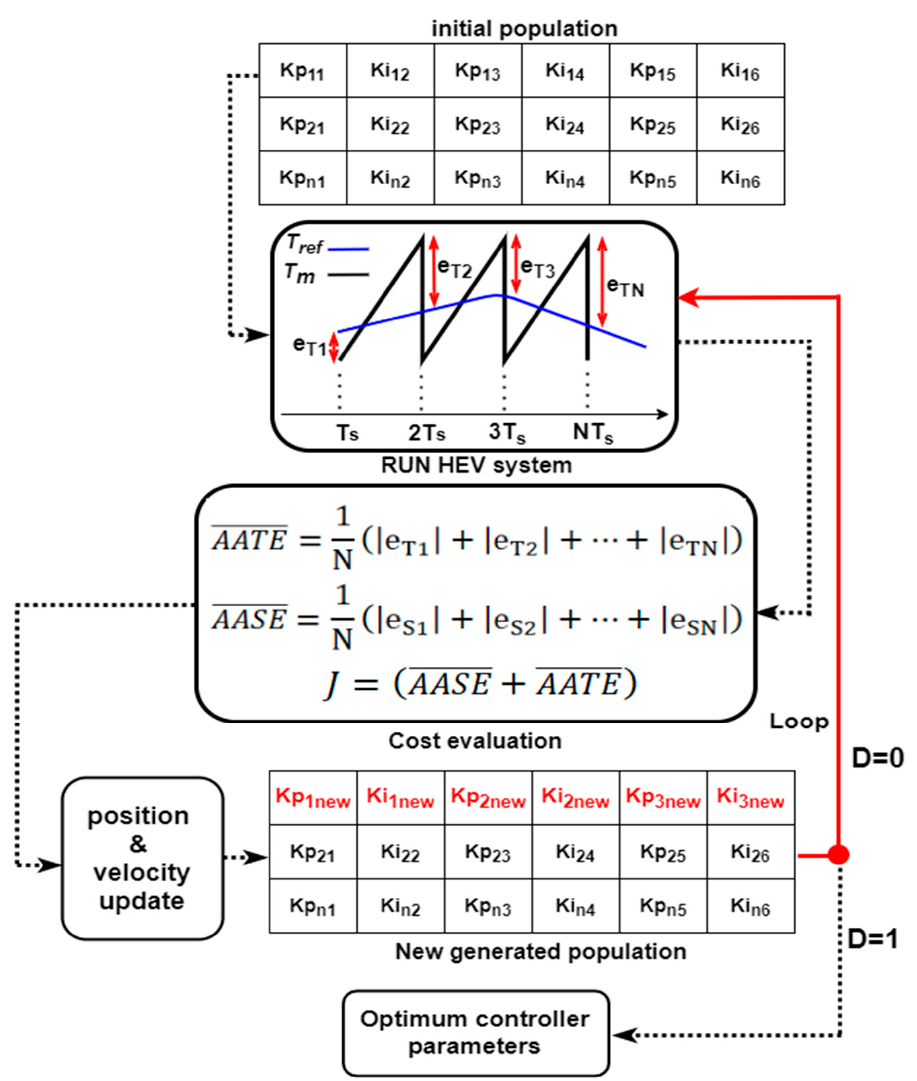
Figure 11. PSO-based tuning of BEV controllers.